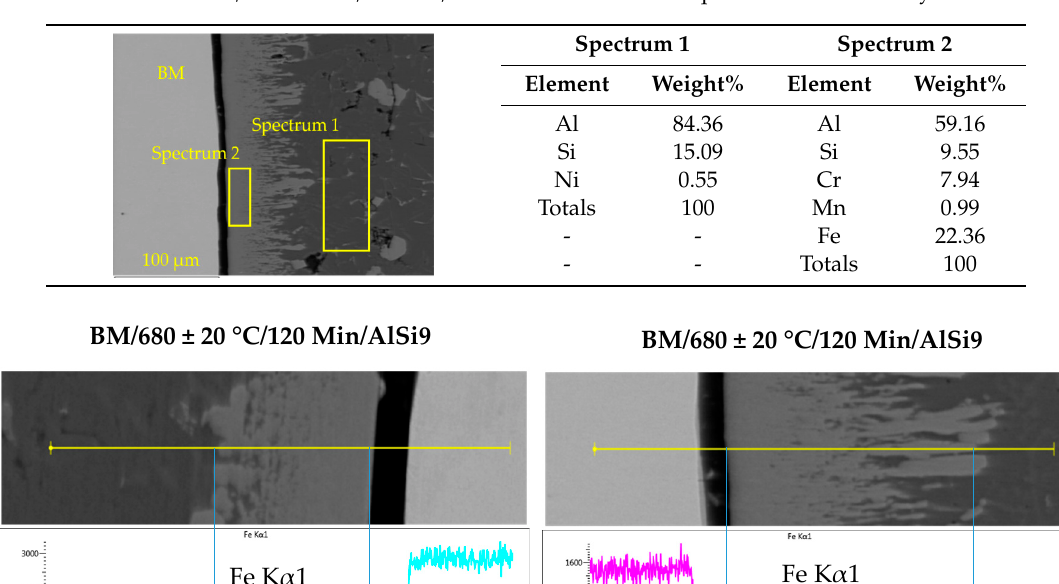
Table 12. BM/680 ± 20 °C/300 min/ENAC-AlSi9. EDX semi-quantitative microanalyses.